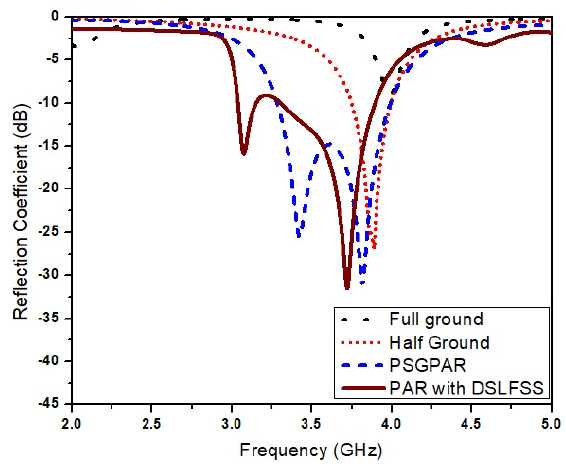
FIGURE 6: Comparative analysis of the design iterations for the reflection coefficient. The simulated design is fabricated and visualized in Figure 7(a), Figure 7(b) and Figure 7(c) for PAR top view, bottom view and DSLFSS top view respectively. The stacked design is fabricated using a set of FR4 substrates and measurements are performed to validate our design for performance in the sub-6 GHz frequency spectrum. The designed prototypes of the DSLFSS and the combination of PAR with DSLFSS are illustrated in Figure